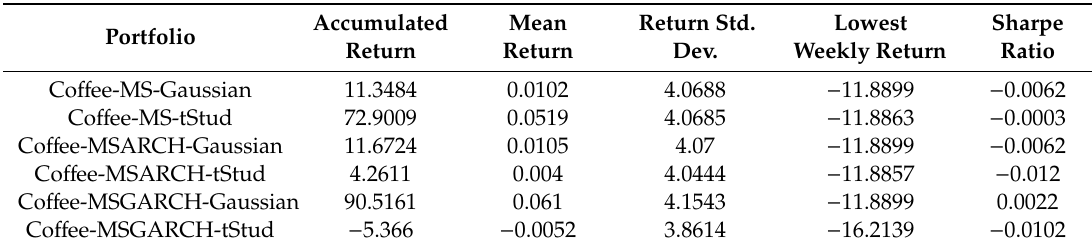
Table 6. Performance summary of the simulated portfolios in the co ff ee one-month futures’ market (figures in %, with the exception of the Sharpe